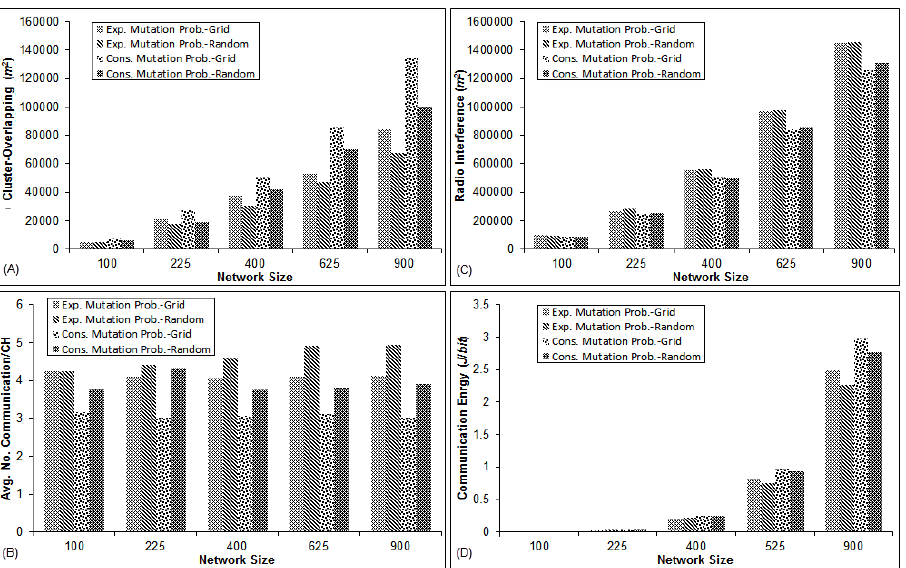
Figure 4. Cluster-overlapping (A), avg. no. of communication/CH (B), radio interference (C), and communication energy (D) versus network sizes for different mutation